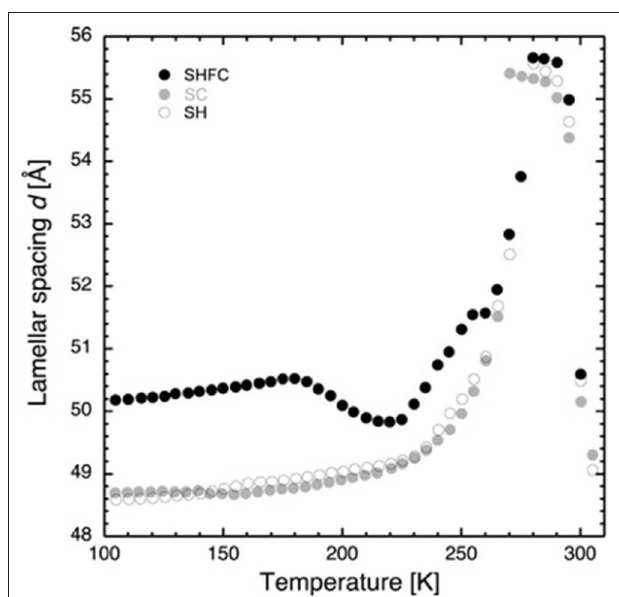
FIGURE 2 | Lamellar spacing of stacks of hydrated DMPC lipids as a function of temperature as determined by neutron diffraction on D16. Closed black circles show the lamellar spacing after flash cooling upon heating from 100 to 300K (SHFC protocol), closed gray circles represent the ones during subsequent slow cooling from 300 to 100K (SC protocol), and open circles show the ones during subsequent slow heating from 100 to 300K (SH protocol). The time interval between successive data points was 30min. The experimental sequence of heating and cooling steps started with flash cooling, followed by SHFC, then SC, and finally SH.